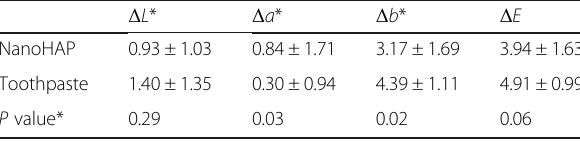
Table 3 Means and standard deviation of Δ L *, Δ a *, Δ b *, Δ E , and t test results of the